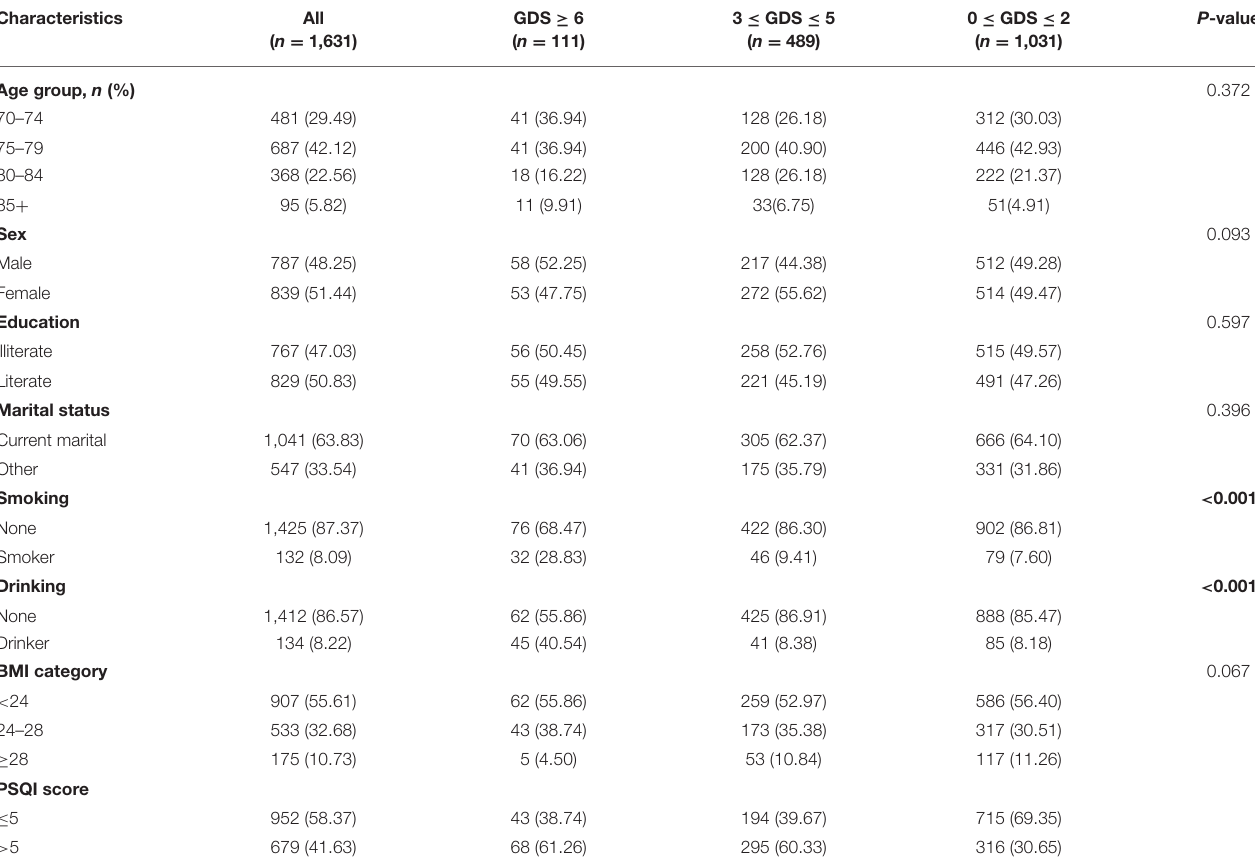
TABLE 1 | Characteristics of participants according to the level of depressive symptoms at baseline.